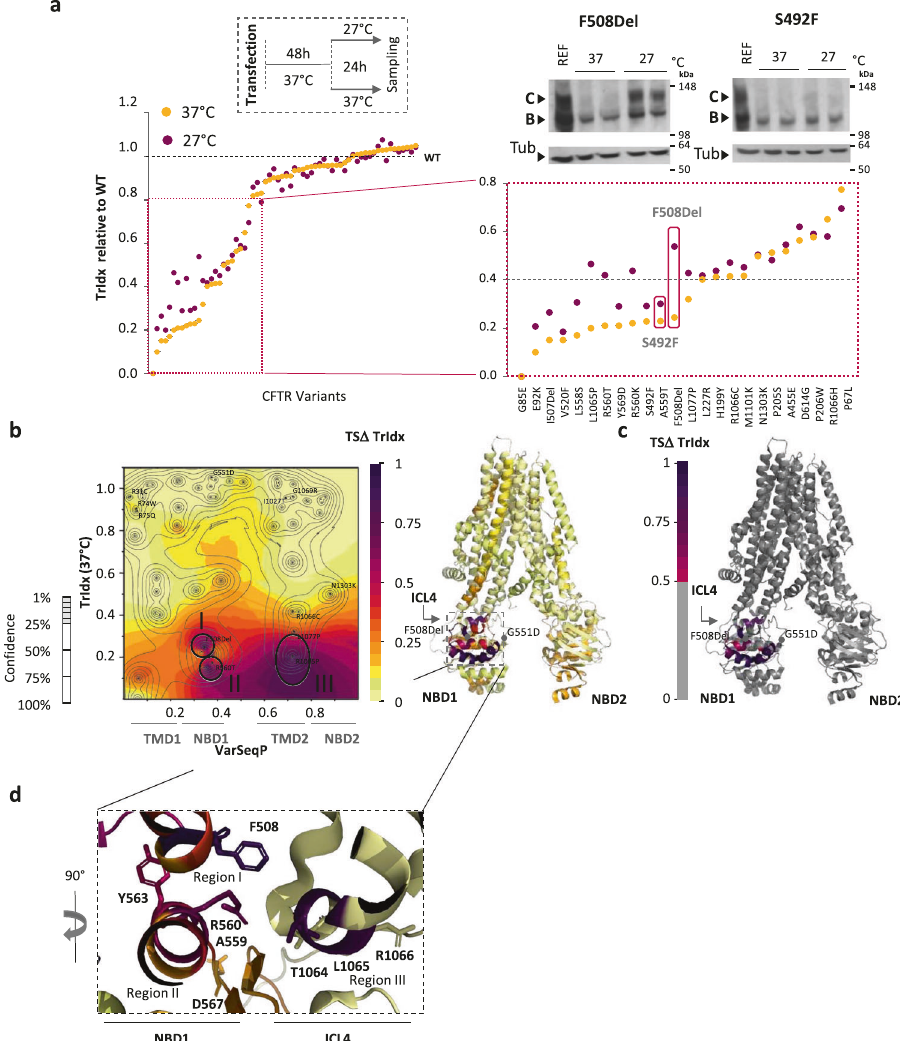
Fig. 3 SCV relationships contributing to the energetics of ER export and traf fi cking. a TrIdx (band C/total (B + C) ratio) of variants relative to WT at 37 °C (orange) and 27 °C (purple) (upper left inset). Variants are ordered from the lowest to the highest TrIdx at 37 °C (left panel). Zoom view of variants with traf fi cking defects <0.8 of WT value (right lower panel). SDS-PAGE of F508del and S492F variants after 24 h at 37 °C or 27 °C showing the difference between F508del (rescued) and S492F (not rescued) in response to reduced temperature (upper right insets). The two lanes per condition represent biological replicates. b (Left panel) SCV predicted temperature shift (TS) delta ( Δ TrIdx (TS Δ TrIdx) phenotype landscape using the VSP-predicted TrIdx at 37 °C ( y -axis) values of the Δ TrIdx between 27 °C and 37 °C ( z -axis) in response to sequence position (VarSeqP, x -axis) overlaid with the con fi dence contour intervals (left panel). (Right panel) The TS Δ TrIdx-phenotype landscape de fi ned functional structure. c Grayout of panel B TS Δ TrIdx functional structure showing only residues with more than 50% of relative correction. The grayout structure highlights in a color gradient the known and predicted unknown residue functions that are likely to display TrIdx correction in response to reduced temperature. d Close-up view of the TrIdx correctability at the interface formed between NBD1/ICL4 including F508, Y563, R560, and D567 (NBD1) and T1064, R1066 (ICL4) in the TS Δ TrIdx functional